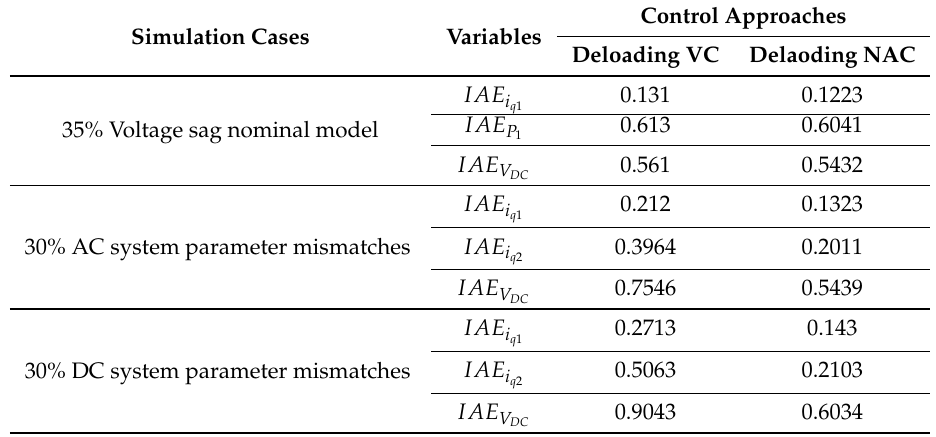
Table 4. Integral of absolute error (IAE) indices (in p.u.) of different control schemes calculated in different